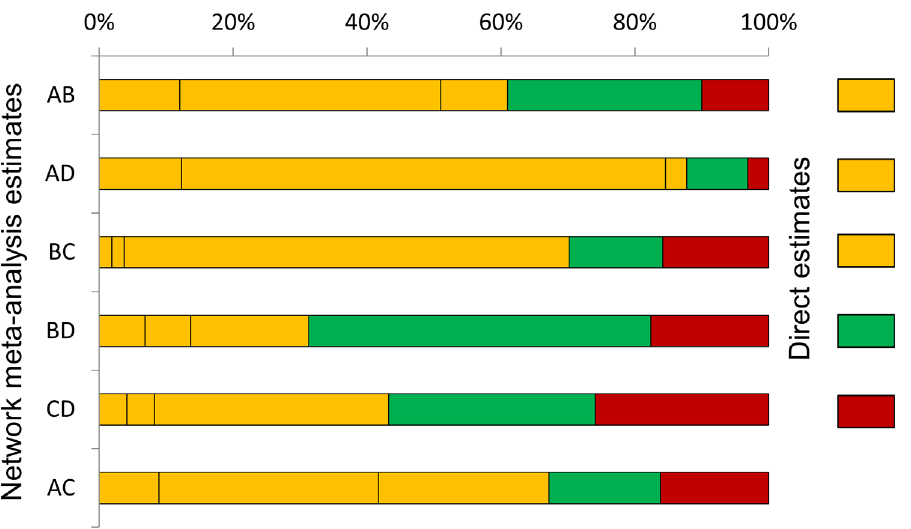
Figure 3. Study limitations for each network estimate for pairwise comparisons of topical antibiotics. Calculations are based on the contributions of direct evidence. The colours represent the risk of bias (green: low, yellow: moderate, red: high). The initial judgements about the risk of bias in the direct estimates are shown on the right side of the figure (there is no direct evidence for AC). The names of the treatments are given in Figure 1.